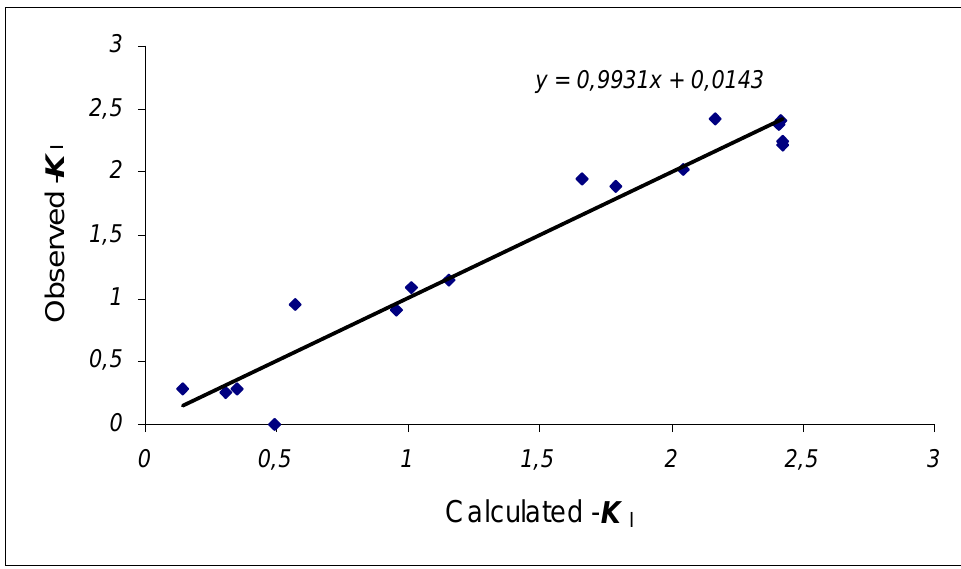
Figure 2. Plot of observed Log K